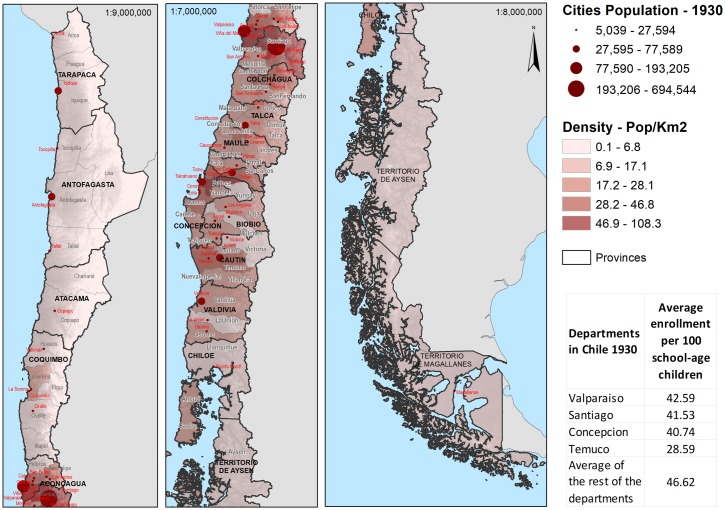
Map of Chile 1930.